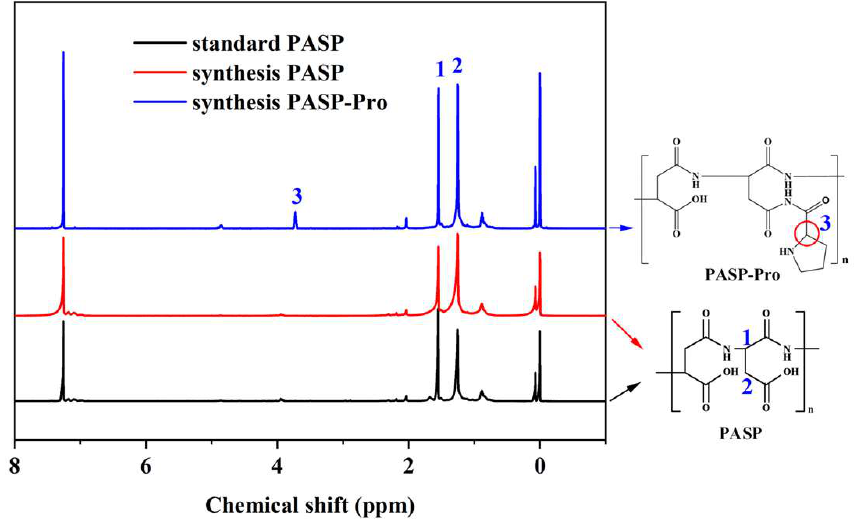
Figure 3. 1 H NMR spectra of PASP and PASP-Pro.